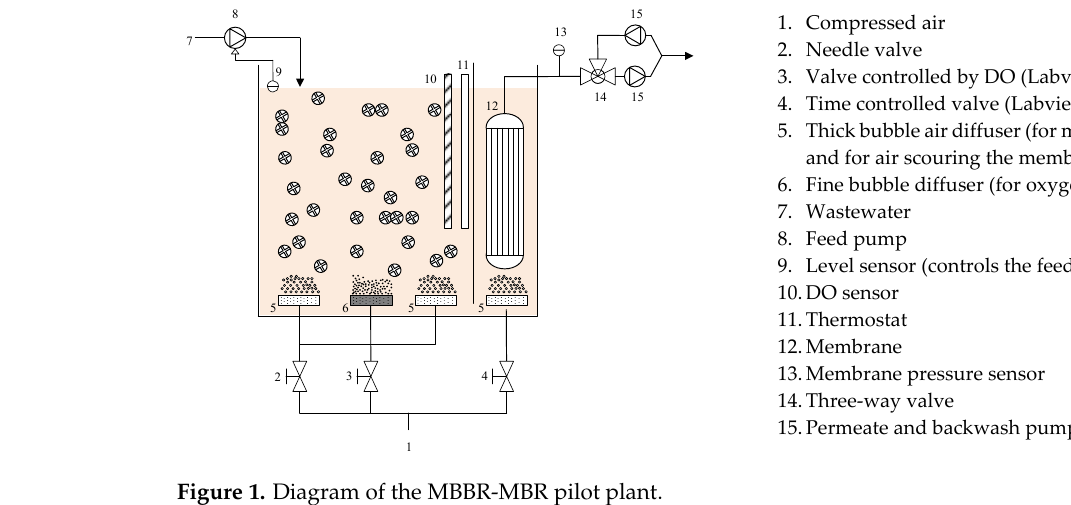
Figure 1. Diagram of the MBBR-MBR pilot plant. Table 2. Carriers characteristics of the MBBR system.